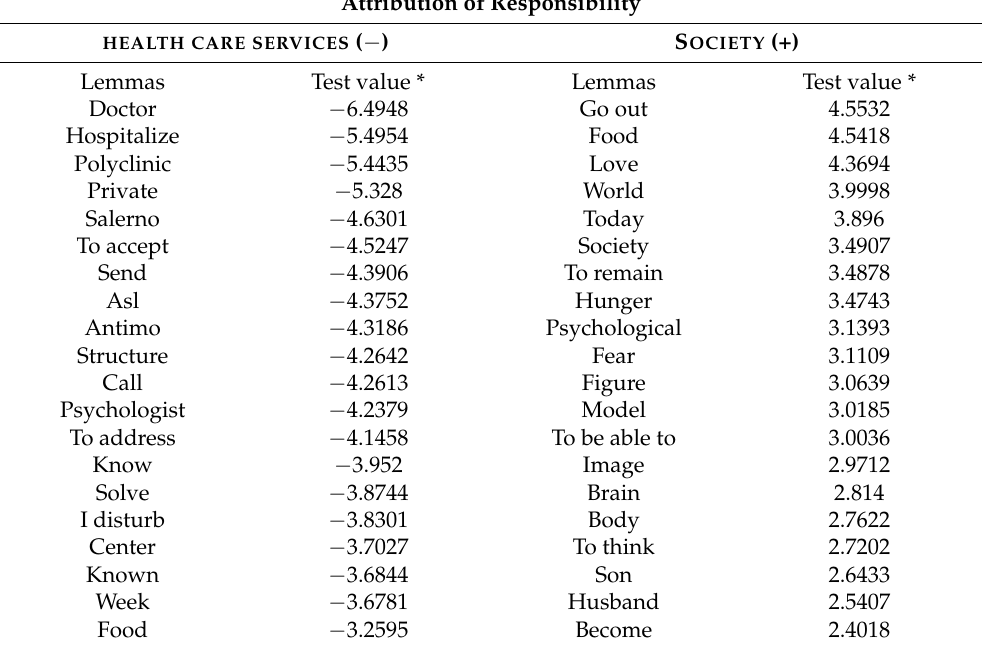
Table 4. Second Factorial Dimension—DS. Attribution of